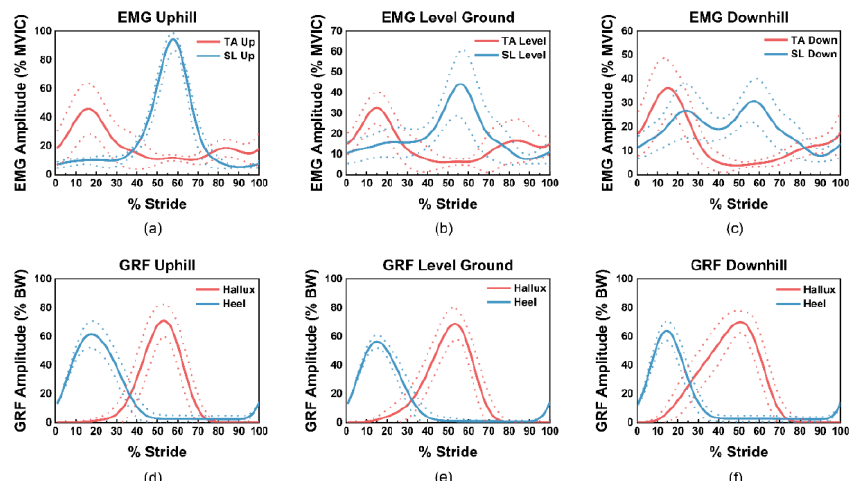
Figure 5. The ensemble average of the EMG and GRF signals with ± 1 SD band in three terrains: ( a – c ) are the tibialis anterior (TA) and soleus (SL) EMG profiles of uphill, level ground and downhill, normalized by the 50% of maximal isometric voluntary contraction (MIVC), respectively. ( d–f ) are the GRF profiles of uphill, level ground and downhill, normalized to the body weight (BW).